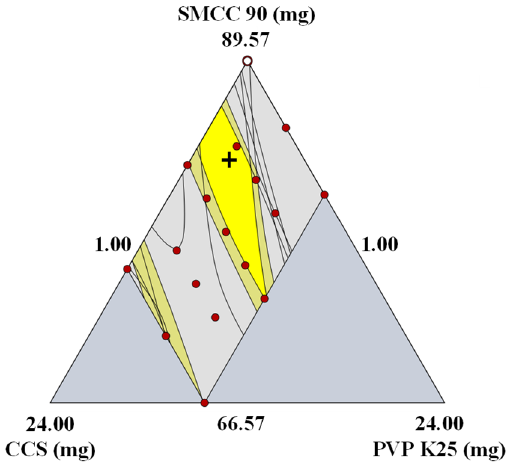
Figure 1. Design space in formulation development. The yellow area corresponds to the 95% confidence interval that satisfies the target values of CQAs. (SMCC, silicified microcrystalline cellulose; CCS, croscarmellose sodium; PVP, polyvinylpyrrolidone).